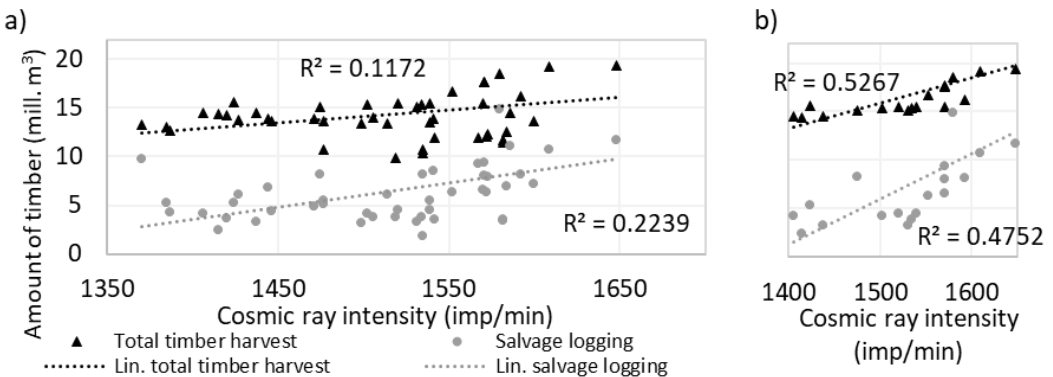
Figure 9. Scatter plot; average annual data on the cosmic ray intensity in relation to salvage logging and the total timber harvested in the Czech Republic in the periods ( a ) 1973–2018 and ( b ) 2000–2018; explanatory notes: Lin.—linear regression model; imp/min—impulses/minute; mill. m 3 —million cubic meters of harvested timber.